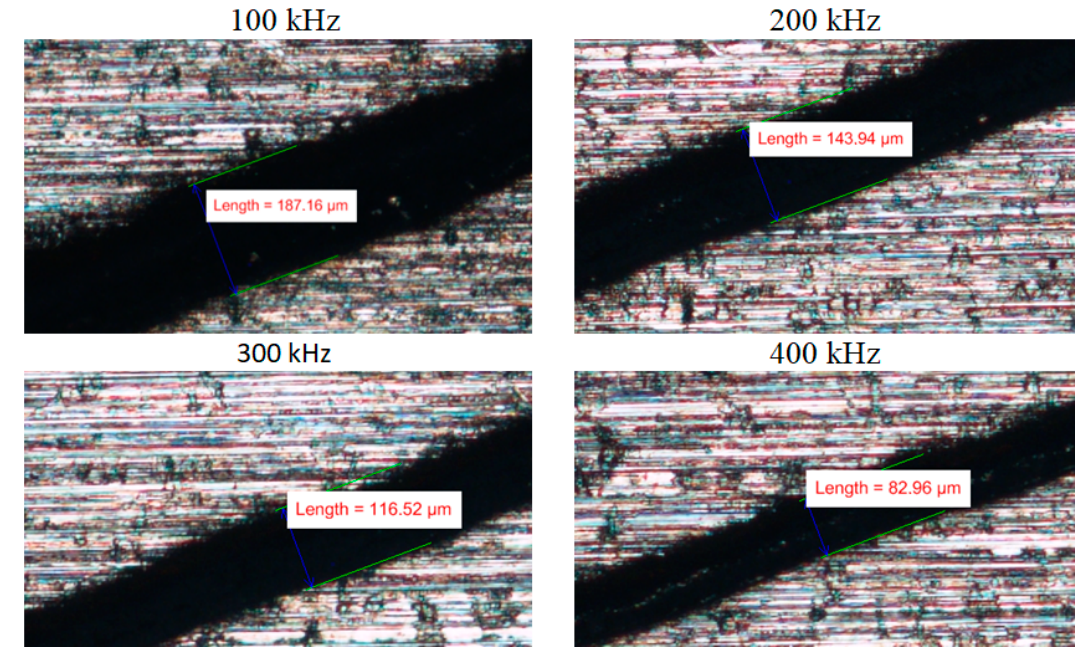
Figure 4. Aluminum sample scribed with sub-picosecond Yb:KYW laser (650 fs, 1030 nm).